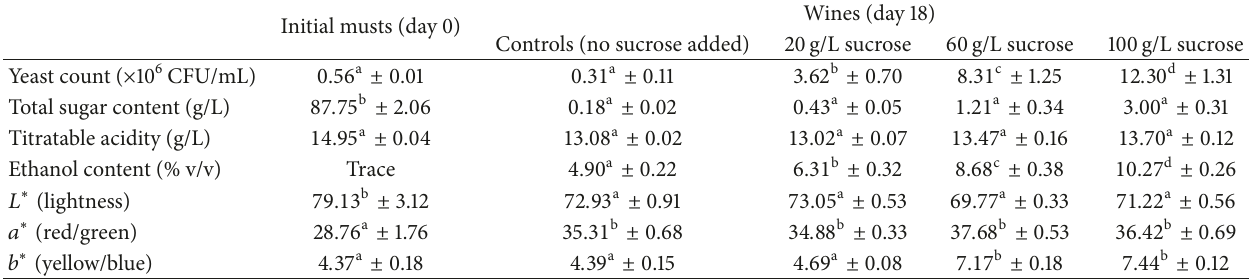
Table 1: Physicochemical characteristics of the initial musts (day 0) and wines added with sucrose and controls (day